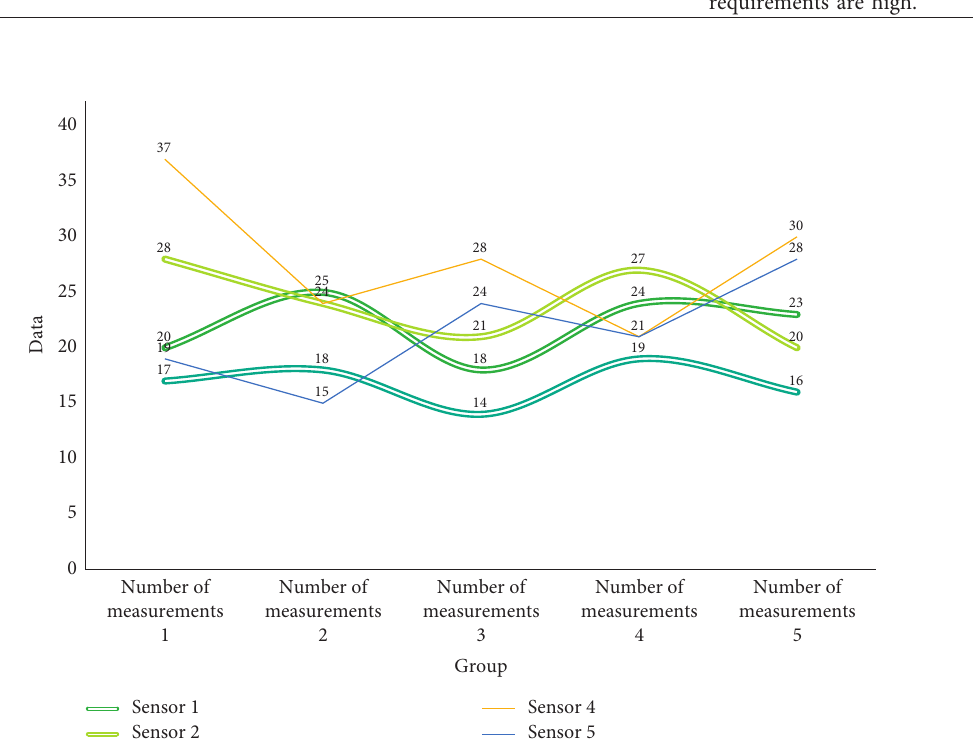
Figure 5: Soil temperature fusion